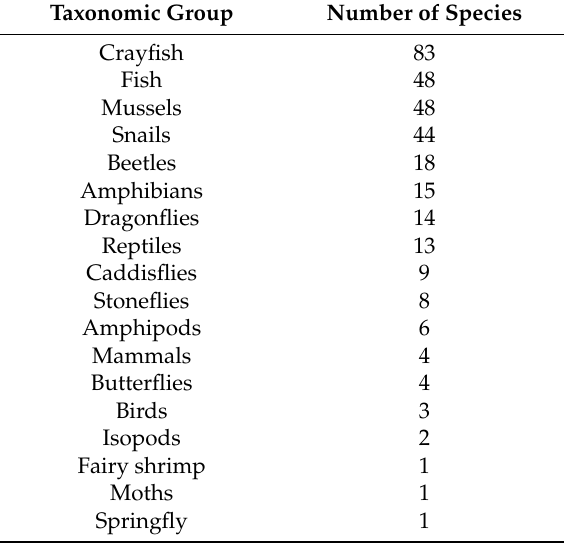
Table 1. Taxonomic groups and the number of species listed in the recent status assessment and the focus of the literature